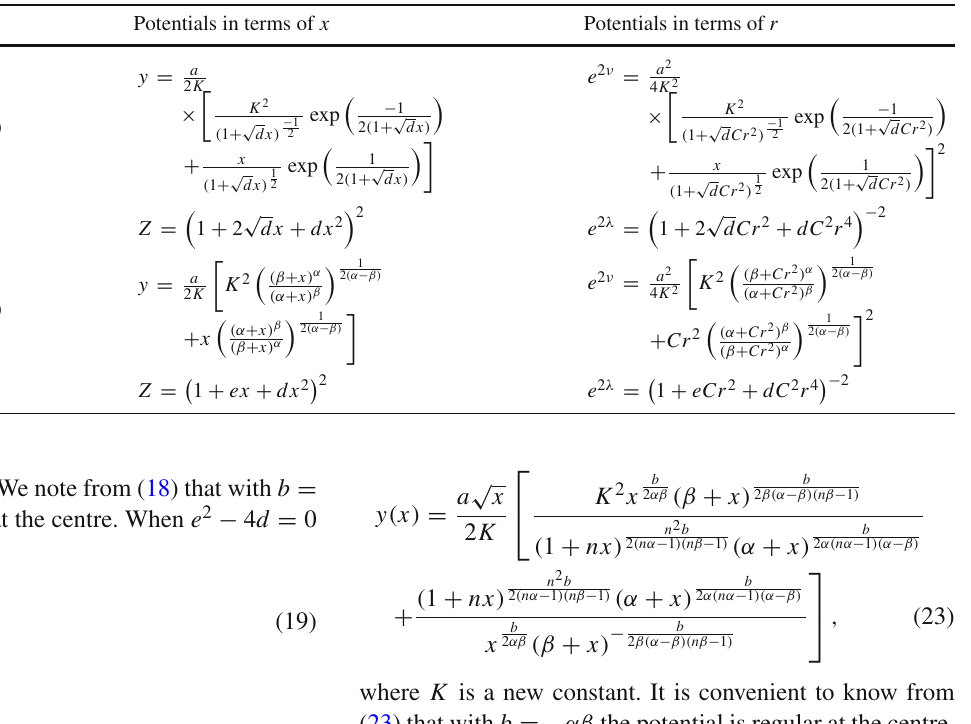
Table 2 Potentials for Class II